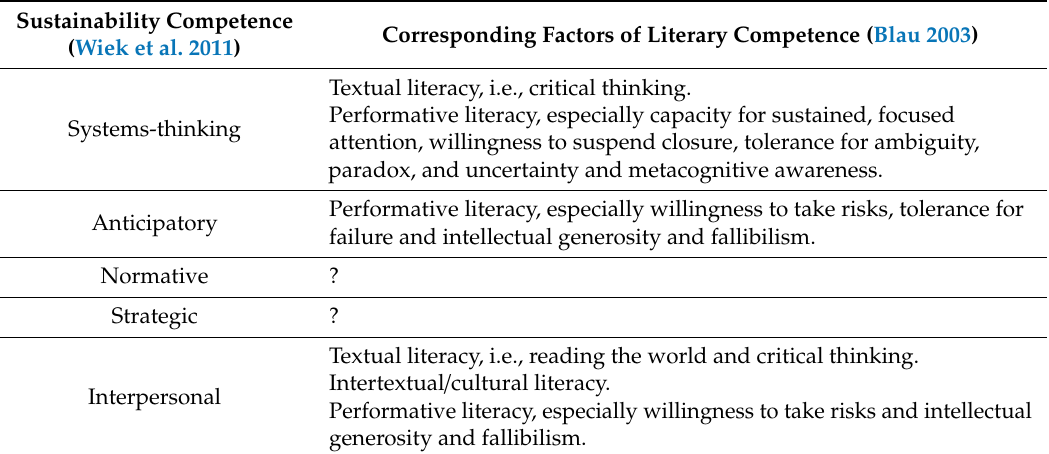
Table 1. The relation between types of sustainability competence and factors of literary